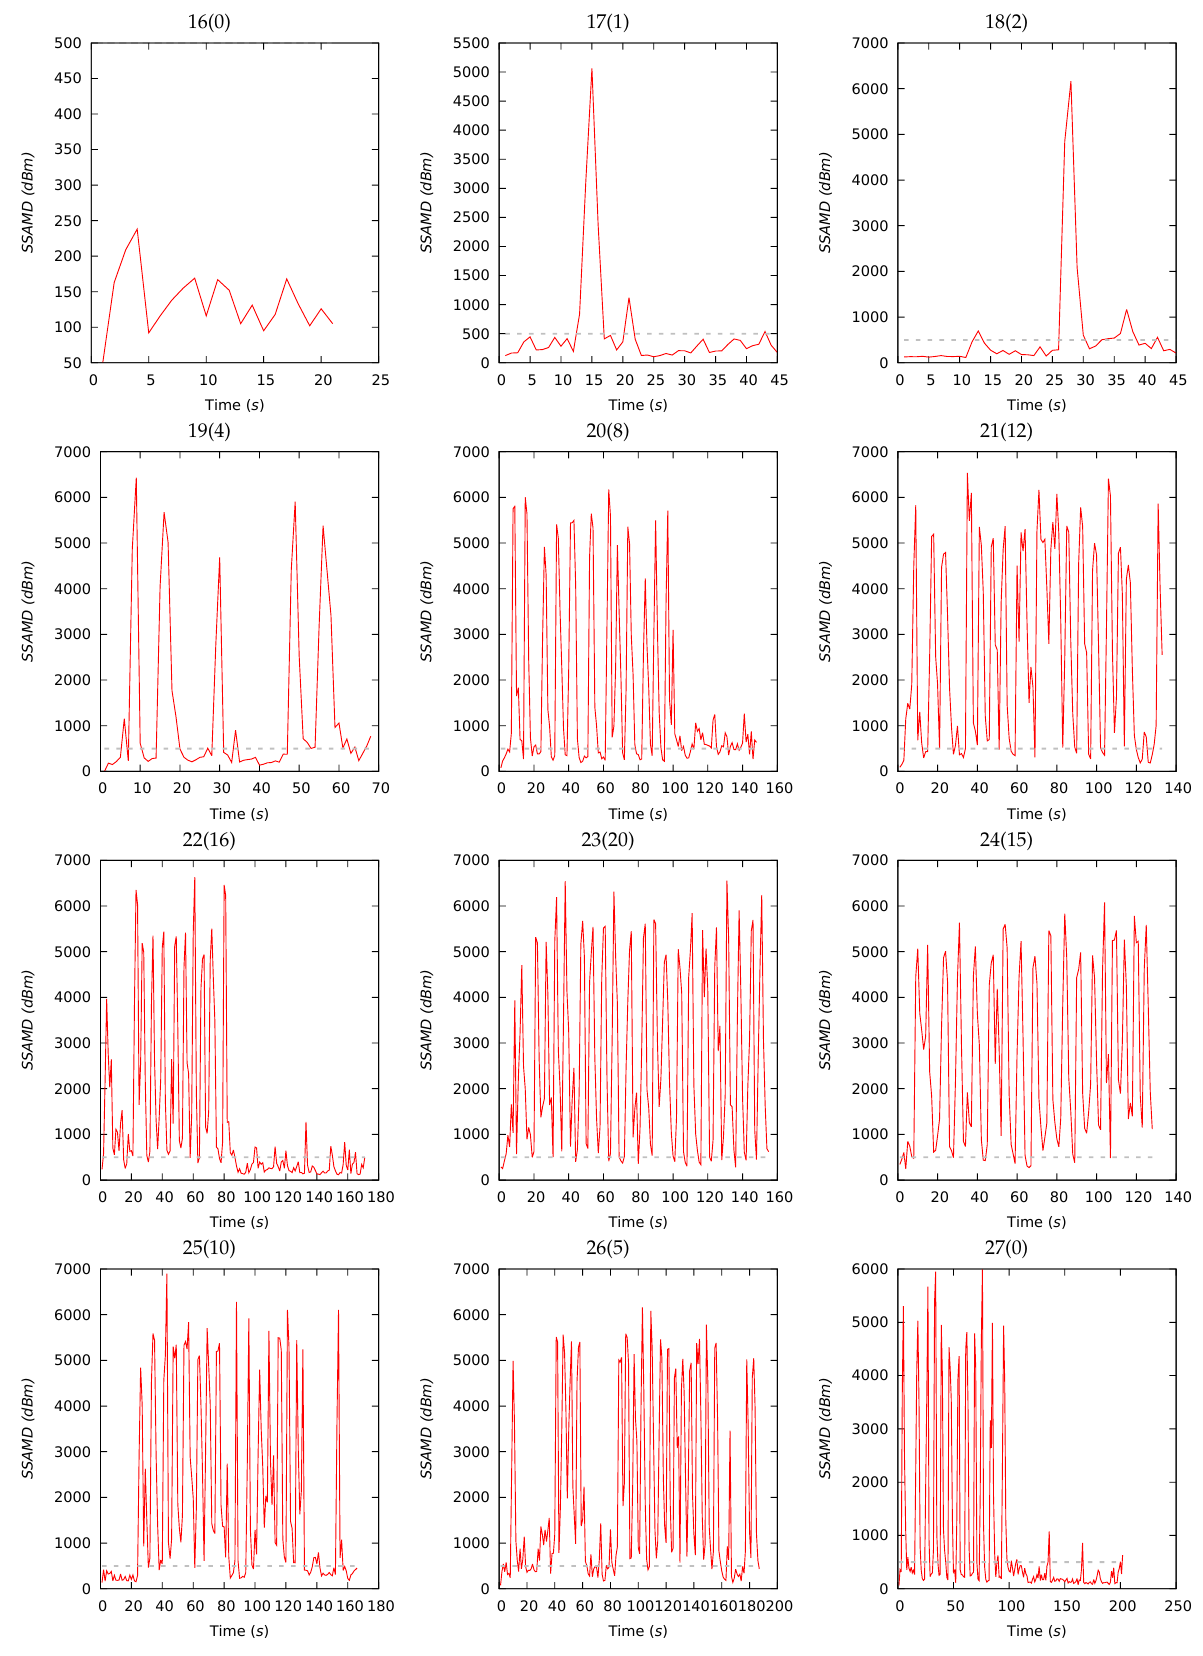
Figure 6. Crickets in the flipped diffuser (shaking